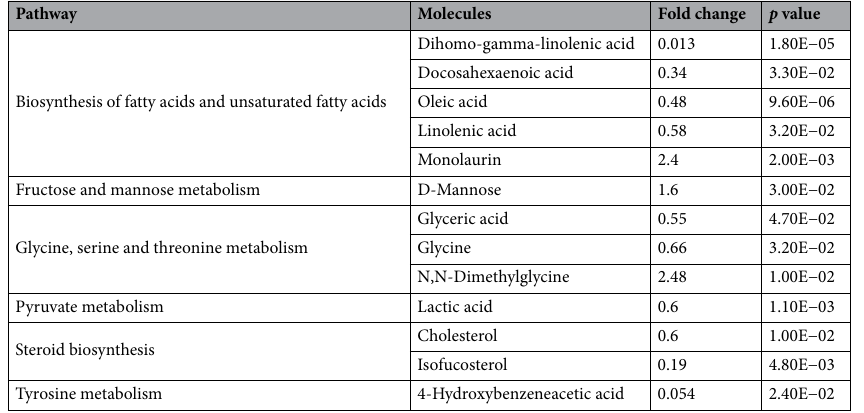
Table 1. Main pathways and molecules that may be involved in protection from SARS-CoV-2 infection. Fold changes and p values are reported.